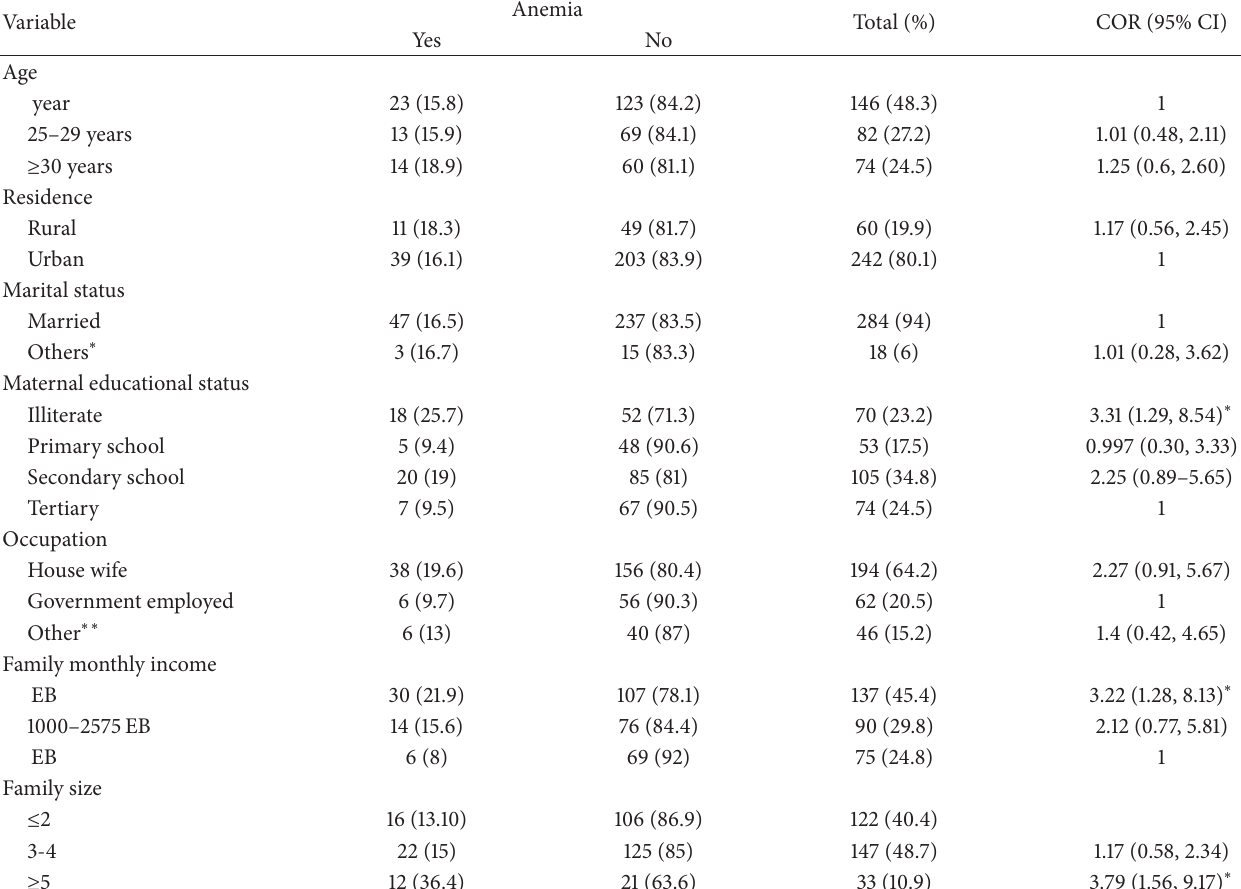
Table 1: Sociodemographic characteristics of pregnant women and prevalence of anemia by sociodemographic characteristics ( 𝑛 = 302 ).